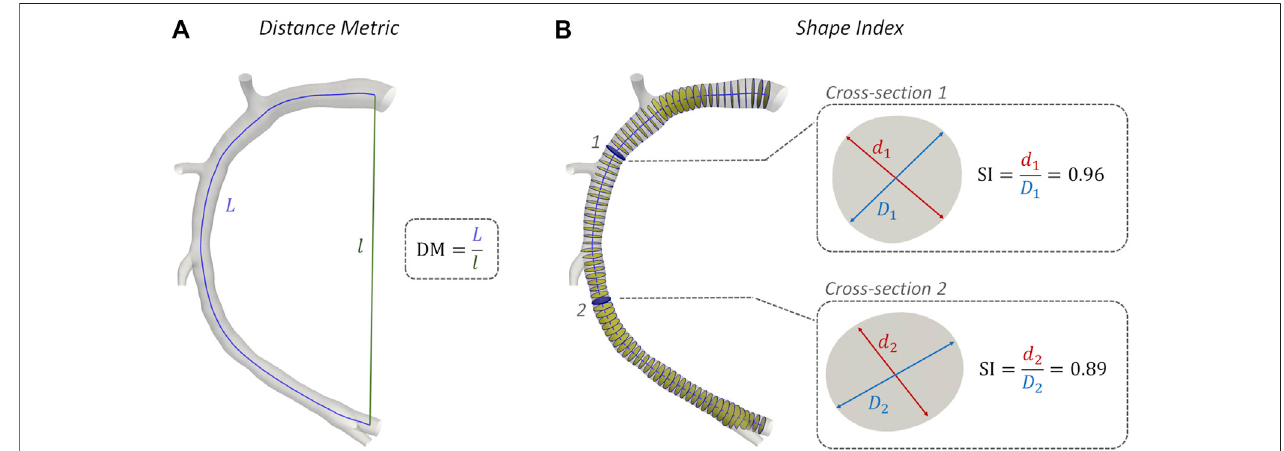
FIGURE 4 | Methodology of Distance Metric (DM) and Shape Index (SI) assessment. Model H1 was taken as explanatory example. (A) DM computing: L and l are the curvilinear (blue) and Euclidean (green) distance between the centerline curve endpoints; (B) SI computation at two explanatory coronary cross-sections along the vessel centerline: d and D are the minimum and maximum diameter of arterial cross-section,